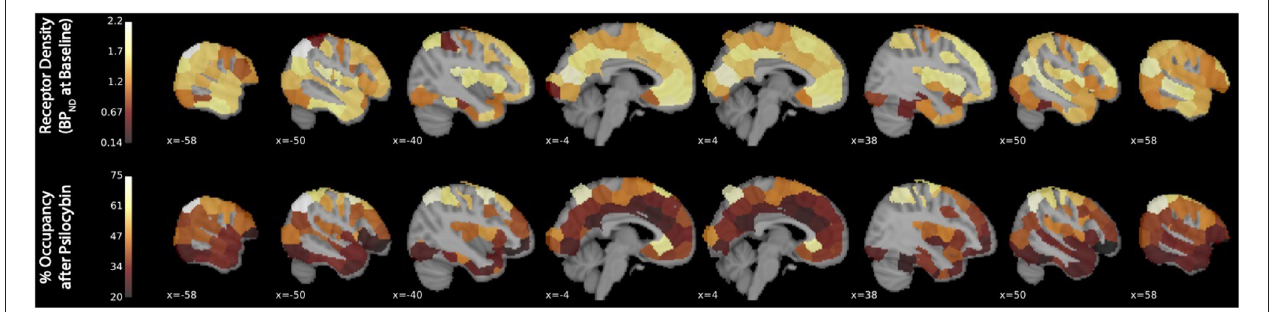
FIGURE 1 | 5-HT 2A receptor binding potential (BP ND ) at baseline and 5-HT 2A receptor occupancy by psilocybin. The x-coordinate of each sagittal brain slice in Montreal Neurological Institute coordinates is presented in the lower-left-hand corner of each panel. The color bar identifying the range of plotted values is presented on the left-hand side of each plot. BP ND is presented in normalized values relative to the reference region (cerebellum). Occupancy by psilocybin is presented in percentages of total possible occupancy.